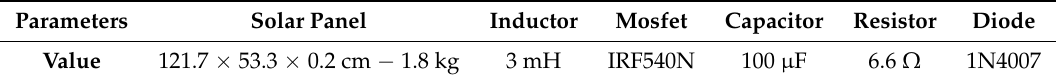
Table 1. The information of solar panel and passive elements for the boost converter.